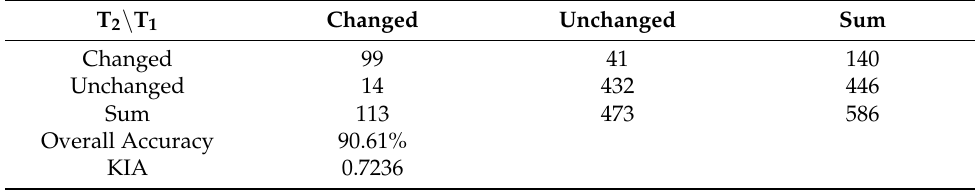
Table 11. Confusion matrix after deleting spurious